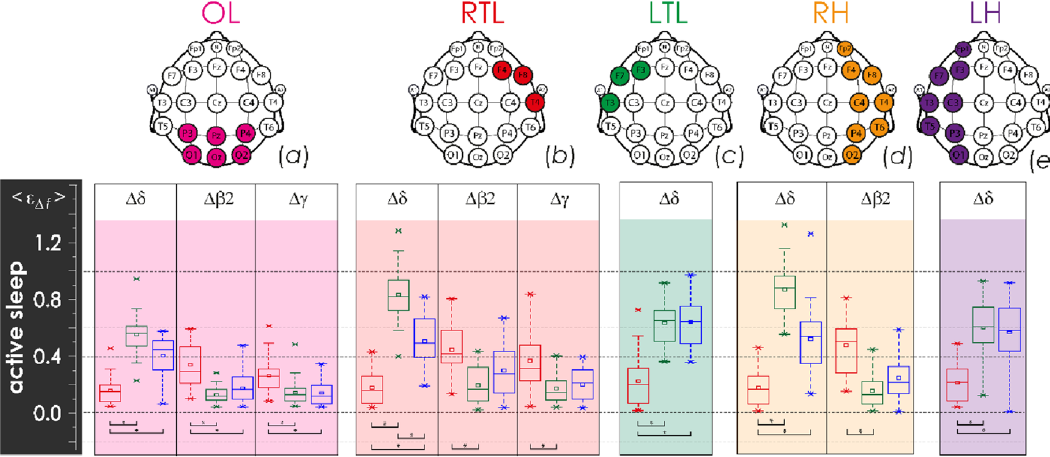
Figure 2. Distributions of the integral averages of relative CWT amplitudes, (cid:31) ε (cid:31) f (cid:30) QS , based on EEG monitoring in newborn groups I and II for the various lobes of the brain, calculated under the physiological state of active sleep (AS): ( a ) diagrams for the occipital lobe (OL); ( b ) diagrams for the right temporal lobe (RTL); ( c ) diagrams for the left temporal lobe (LTL); ( d ) diagrams for the right hemisphere (RH); ( e ) diagrams for the left hemisphere (LH). The localization of EEG channels on the scalp for each brain lobe is shown above. Red color indicates estimates for group II (EEG monitoring event GA34–37 10d ), green and blue colors code the estimates of the first and second monitoring events in group I, GA38–41 8h and GA38–41 10d , respectively. The diagrams depict the following statistical characteristics of numerical indicators: the first and the third quartiles (25–75%, inside the box), the median and the mean (transverse line and point inside the box, respectively), 1.5 interquartile ranges (shown by whiskers), and outliers represented by asterisks. At the bottom, underlining with asterisks highlights the pairs of values meeting the Mann–Whitney test with p < 0.001.